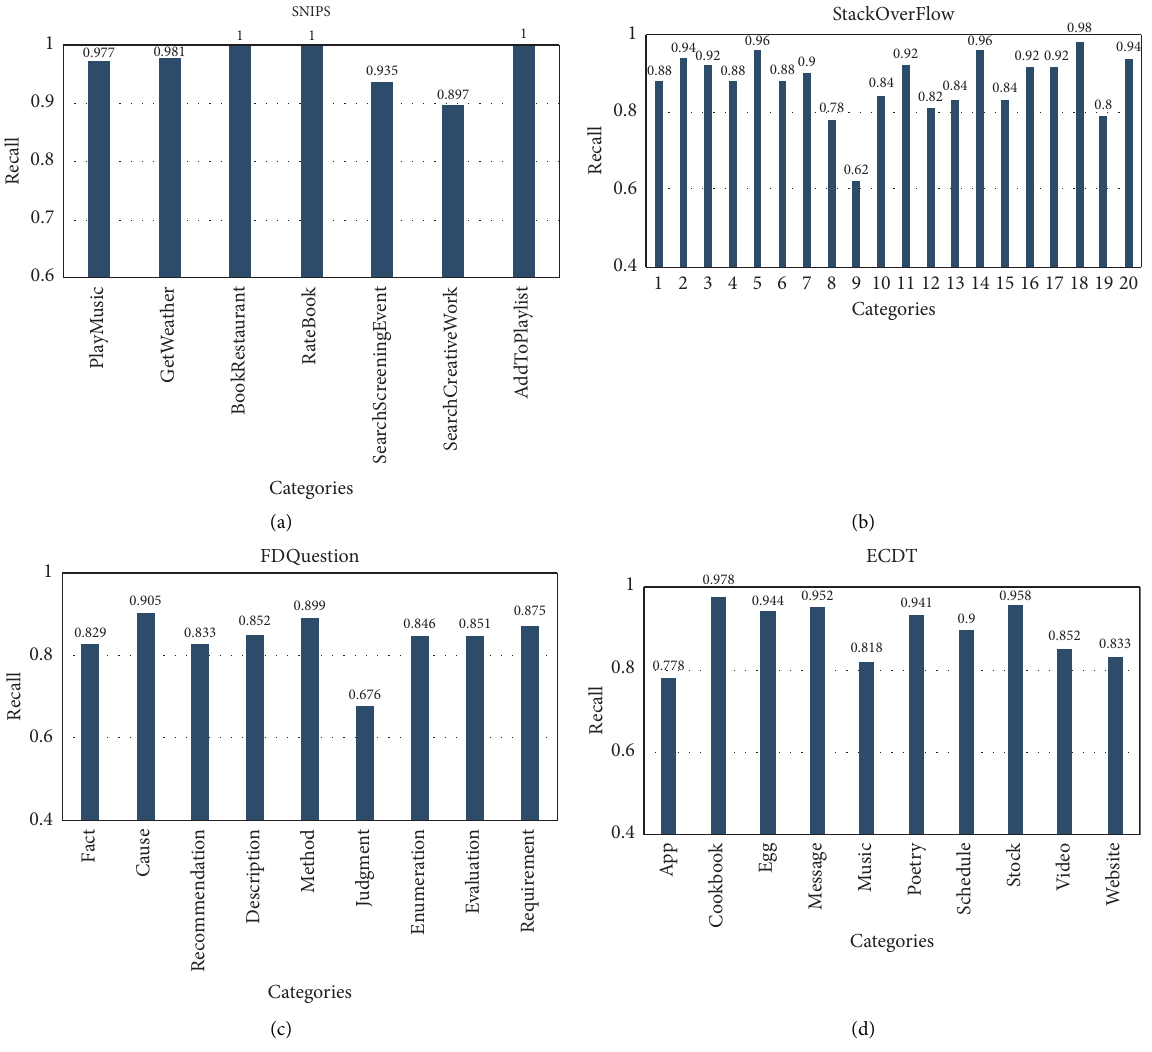
Figure 2: The recall comparison of each category on the four datasets including (a) SNIPS, (b) StackOverFlow, (c) FDQuestion, and (d) ECDT.